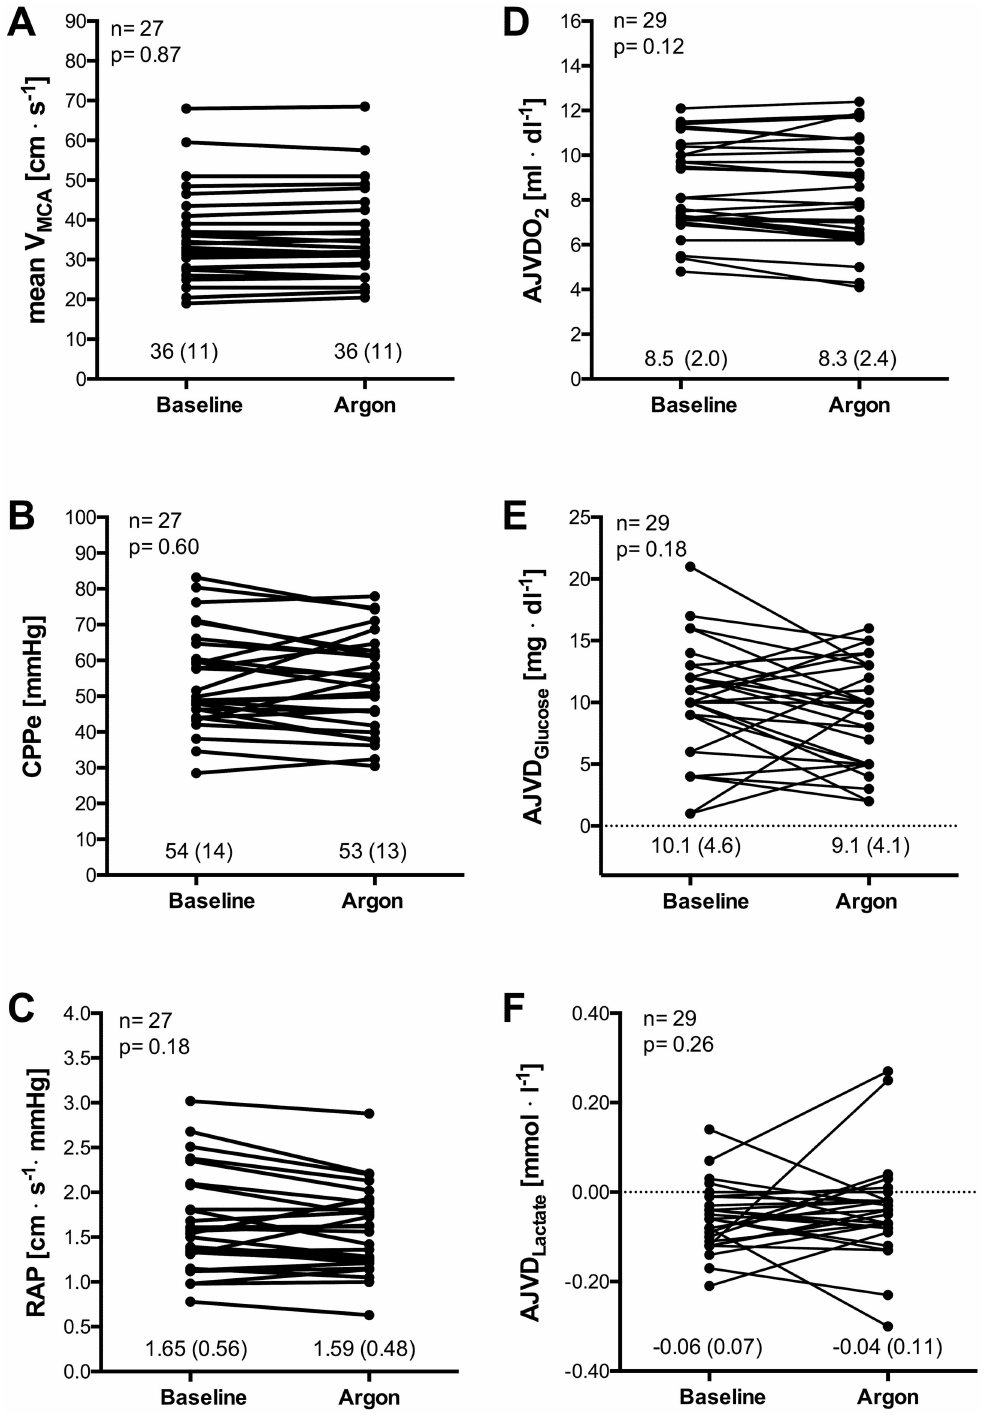
Fig 1. Effect of argon inhalation on cerebral circulation and metabolism. Valuesof mean blood flow velocity of the middlecerebralartery (Vmca), effective cerebralperfusionpressure(CPPe), resistancearea product (RAP), arterio-jugular venous differencesin oxygen (AJVDO 2 ) glucose(AJVDG), and lactate (AJVDL) during baseline(70%N 2 /30%O 2 ) comparedwith argon inhalation(70%Ar/30%O 2 ). Straight lines link individual values for each subject. Data are mean (SD) for each measurement. The P values, which refer to the difference betweentwo measurement points, were calculatedusing two-sidedt-test for paired data. Due to artefacts duringTCD recording,data of patient 1 and 5 have been excludedfrom respectiveanalysis§ n = 28, * n = 27.